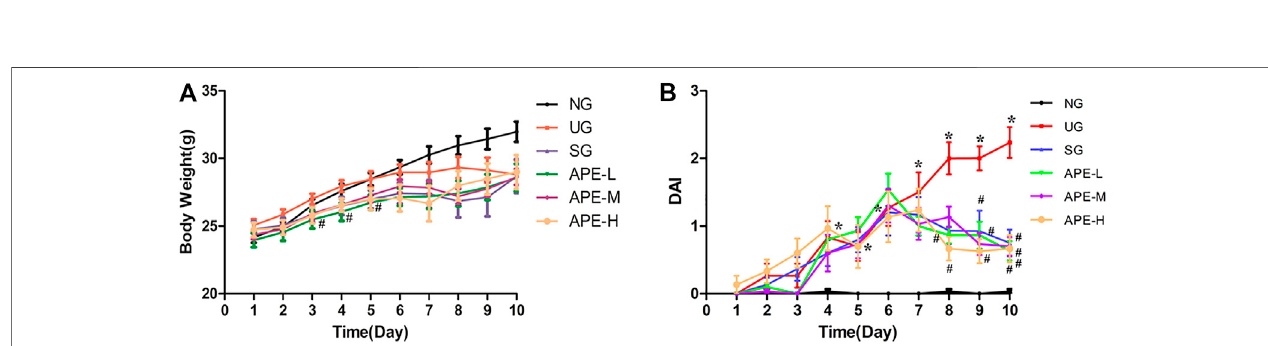
FIGURE3| Effects ofAPE onthebody weight (A) andDAI (B) ineach group. n (cid:2) 10foreach group.* p < 0.05,** p < 0.01vs. NG. # p < 0.05, ## p < 0.01vs. UG.APE, Alhagi pseudalhagi extract; DAI, disease activity index; NG, normal group; UG, ulcerative colitis model group; APE-H, high-dose APE group; APE-M,middle-dose APE group; APE-L, low-dose APE group.